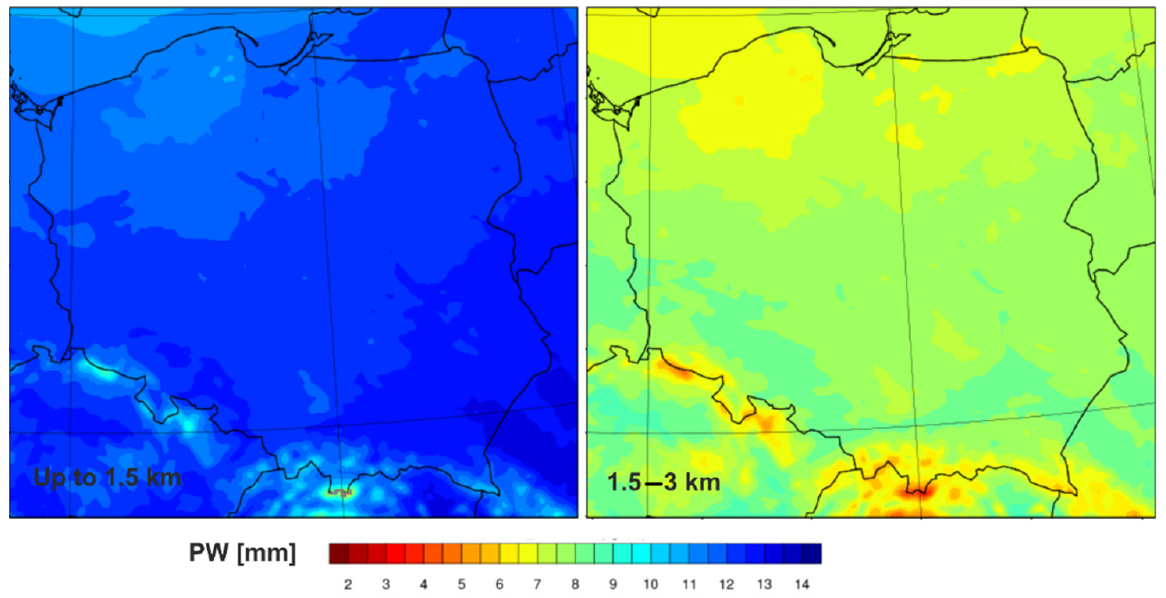
Figure 11. PW summer values (mm) at the level up to 1.5 km and from 1.5 to 3.0 km over Poland. Grids excluded from the analysis are in gray.